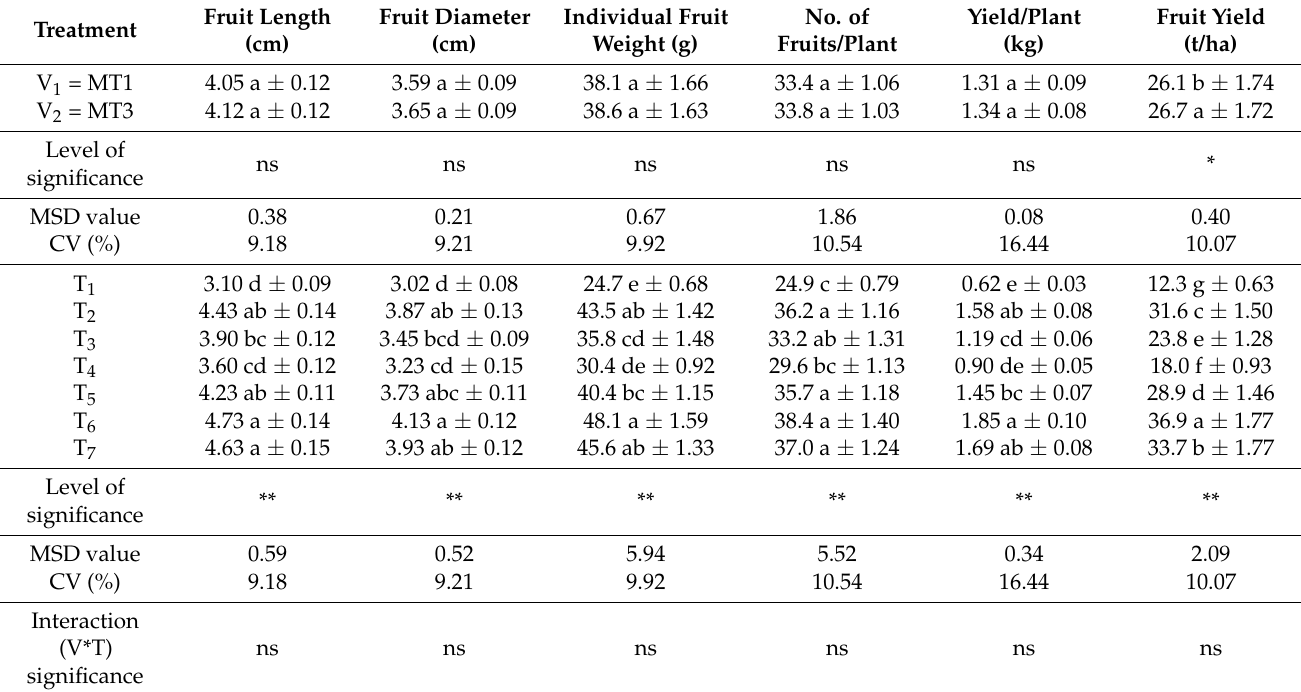
Table 4. Effect of zinc fertilizer and zinc oxide nanoparticles on the yield and yield attributes of two selected tomato